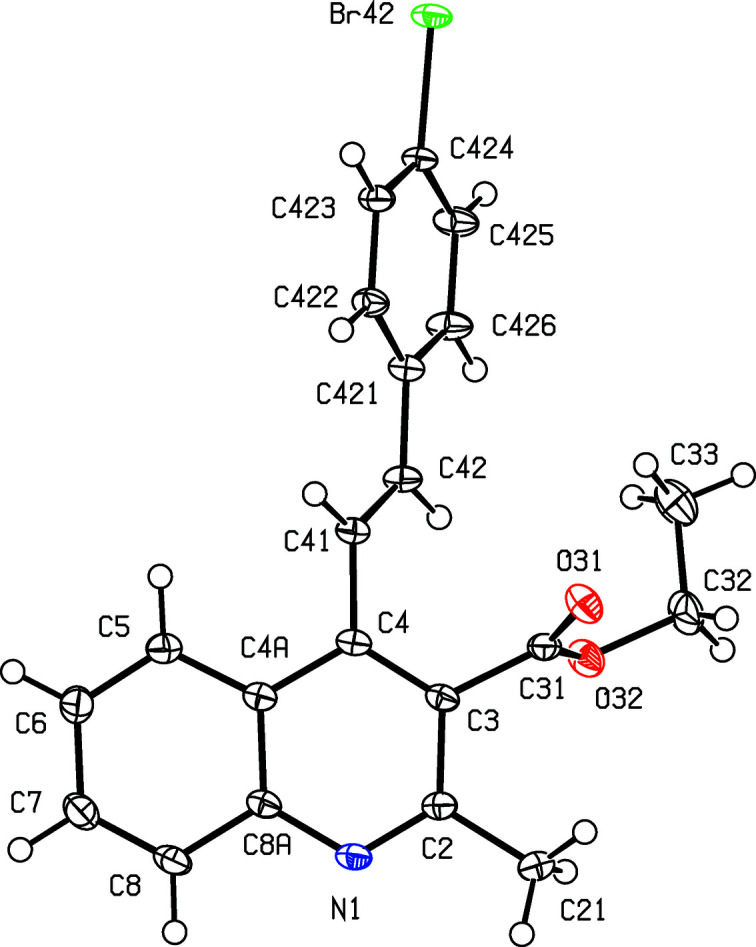
The mol­ecular structure of com­pound (V), showing the atom-labelling scheme. Displacement ellipsoids are drawn at the 50% probability level.